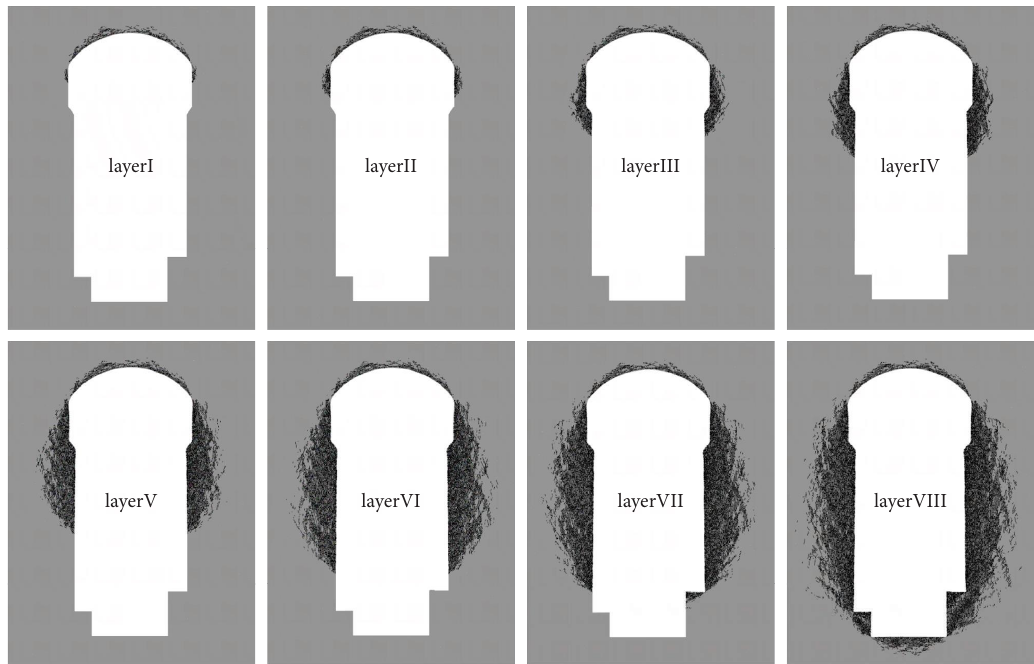
Figure 4: Fracture process of surrounding rock during layered excavation of right bank powerhouse.